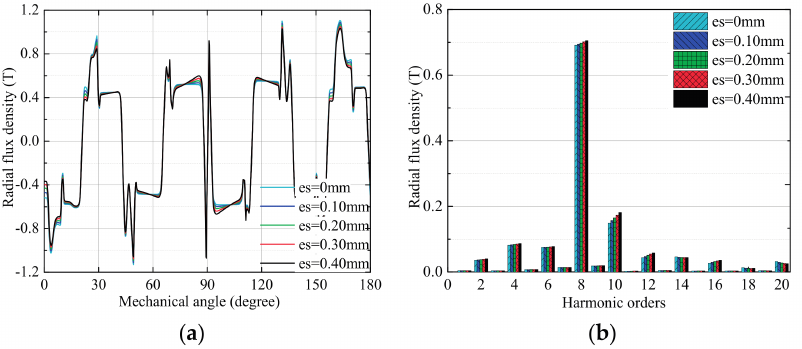
Figure 7. Analysis of the radial component of magnetic flux density in the IPMSM with stator deformation at high-speed load condition. ( a ) Distribution curves; ( b ) Harmonic contents.